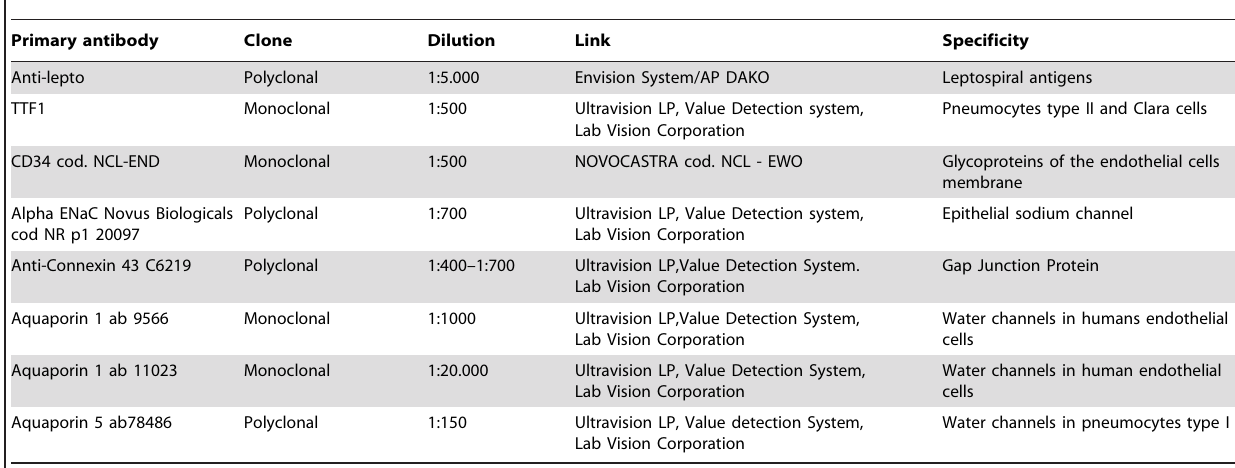
Table 2. Immunohistochemical protocols – essential data.